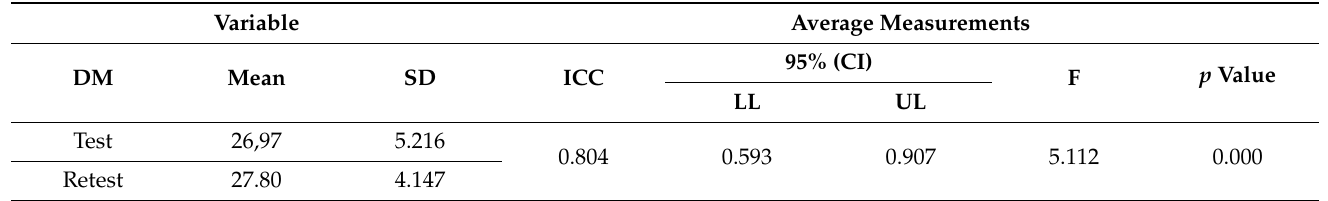
Table 4. Values in the ICC in the test–retest assessment of Direction of Movement (DM) and aver- age measurement.